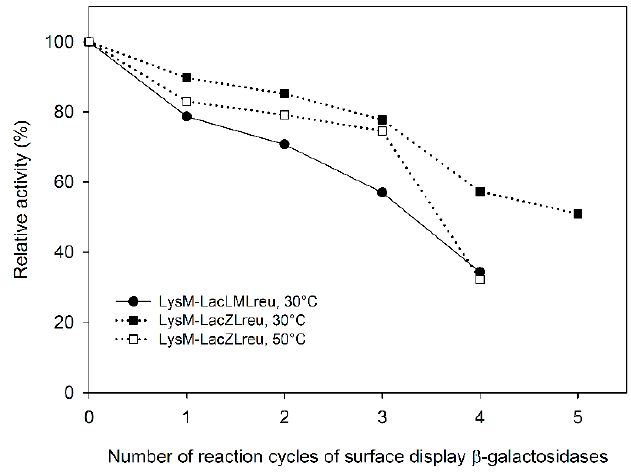
Figure 5. Enzymatic activity of surface display β -galactosidases, LysM-LacLMLreu- and LysM-LacZLbul, during several repeated rounds of lactose conversion using L. plantarum WCFS1 displaying cells. Experiments were performed in duplicates, and the standard deviation was always less than 5%.